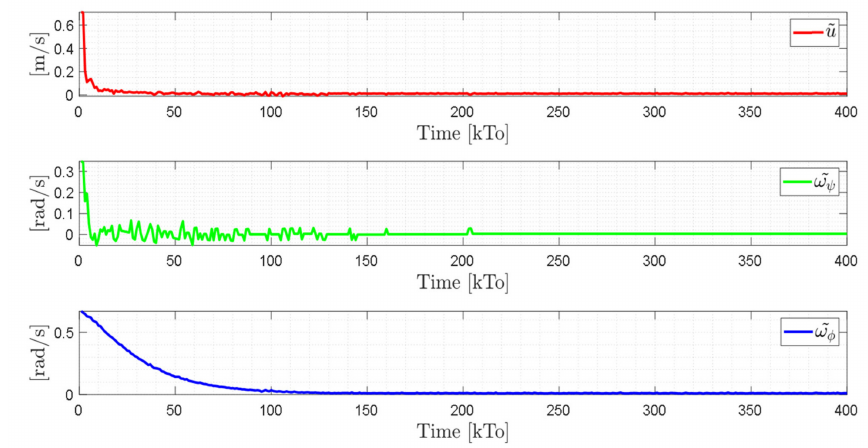
Figure 15. Velocity commands to the standing wheelchair µ ref ( kT 0 ) = ( µ x , ω ψ